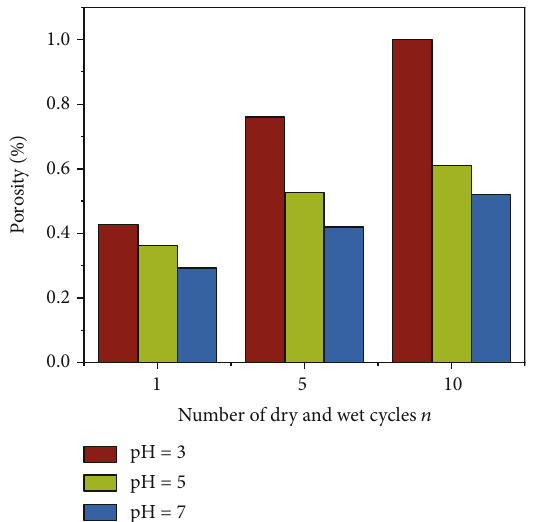
Figure 5: Relationship between average porosity and number of dry-wet cycles.